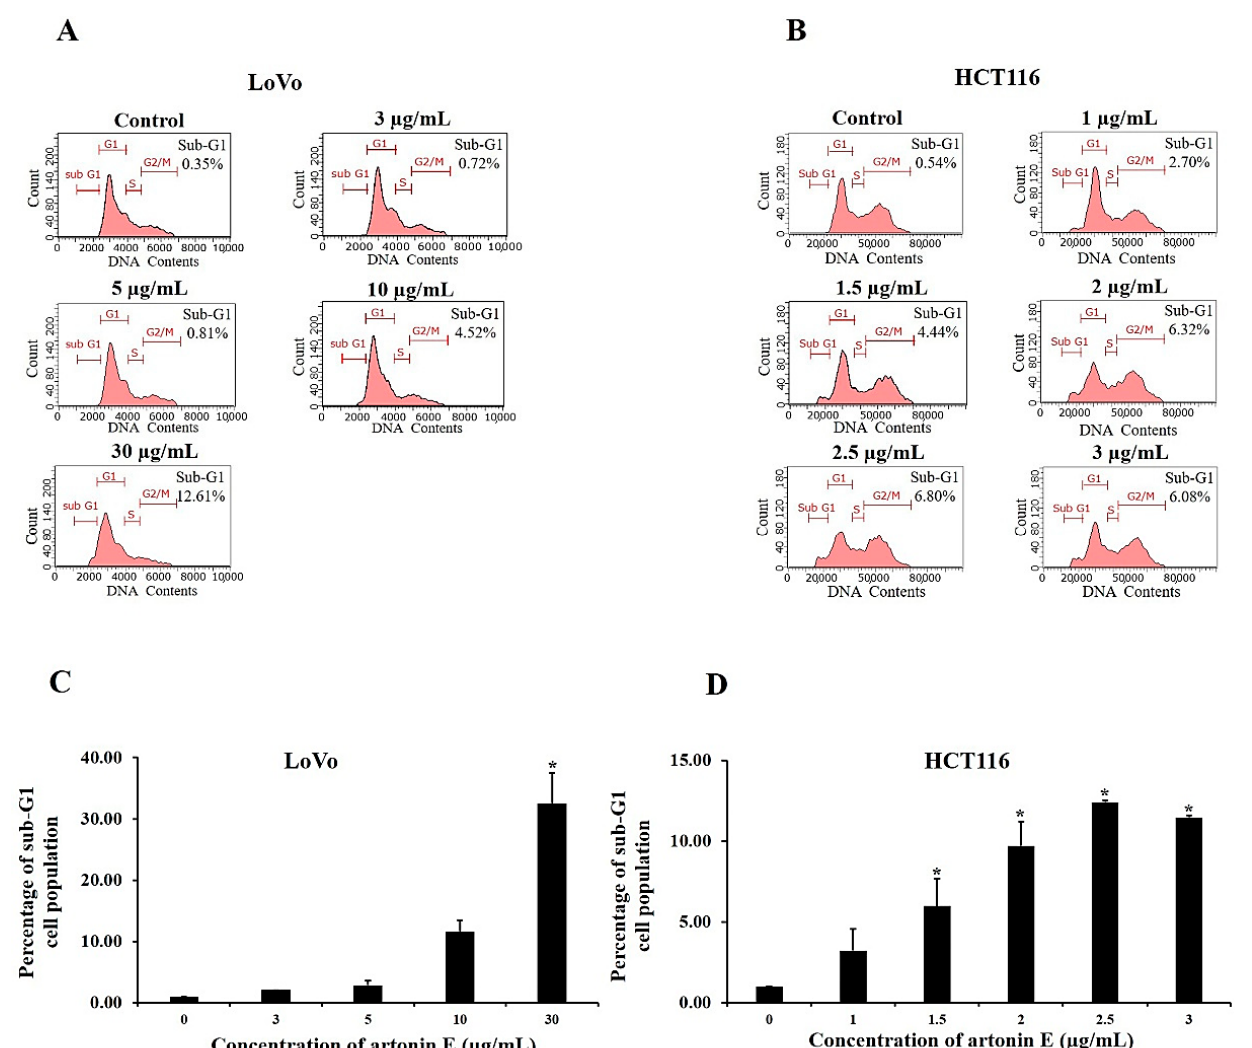
Figure 4. Effect of artonin E on cell cycle distribution. The sub-G1 population was formed with re- duced DNA content representing the presence of apoptotic cells. The mean apoptotic population of cells after treatment with artonin E for 24 h for ( A ) LoVo and ( B ) HCT116 cells. Quantification of % of cells under the sub-G1 peak of ( C ) LoVo cells and ( D ) HCT116 cells. The data are presented as mean ± SD (n = 3). * p < 0.05 compared with the control group.